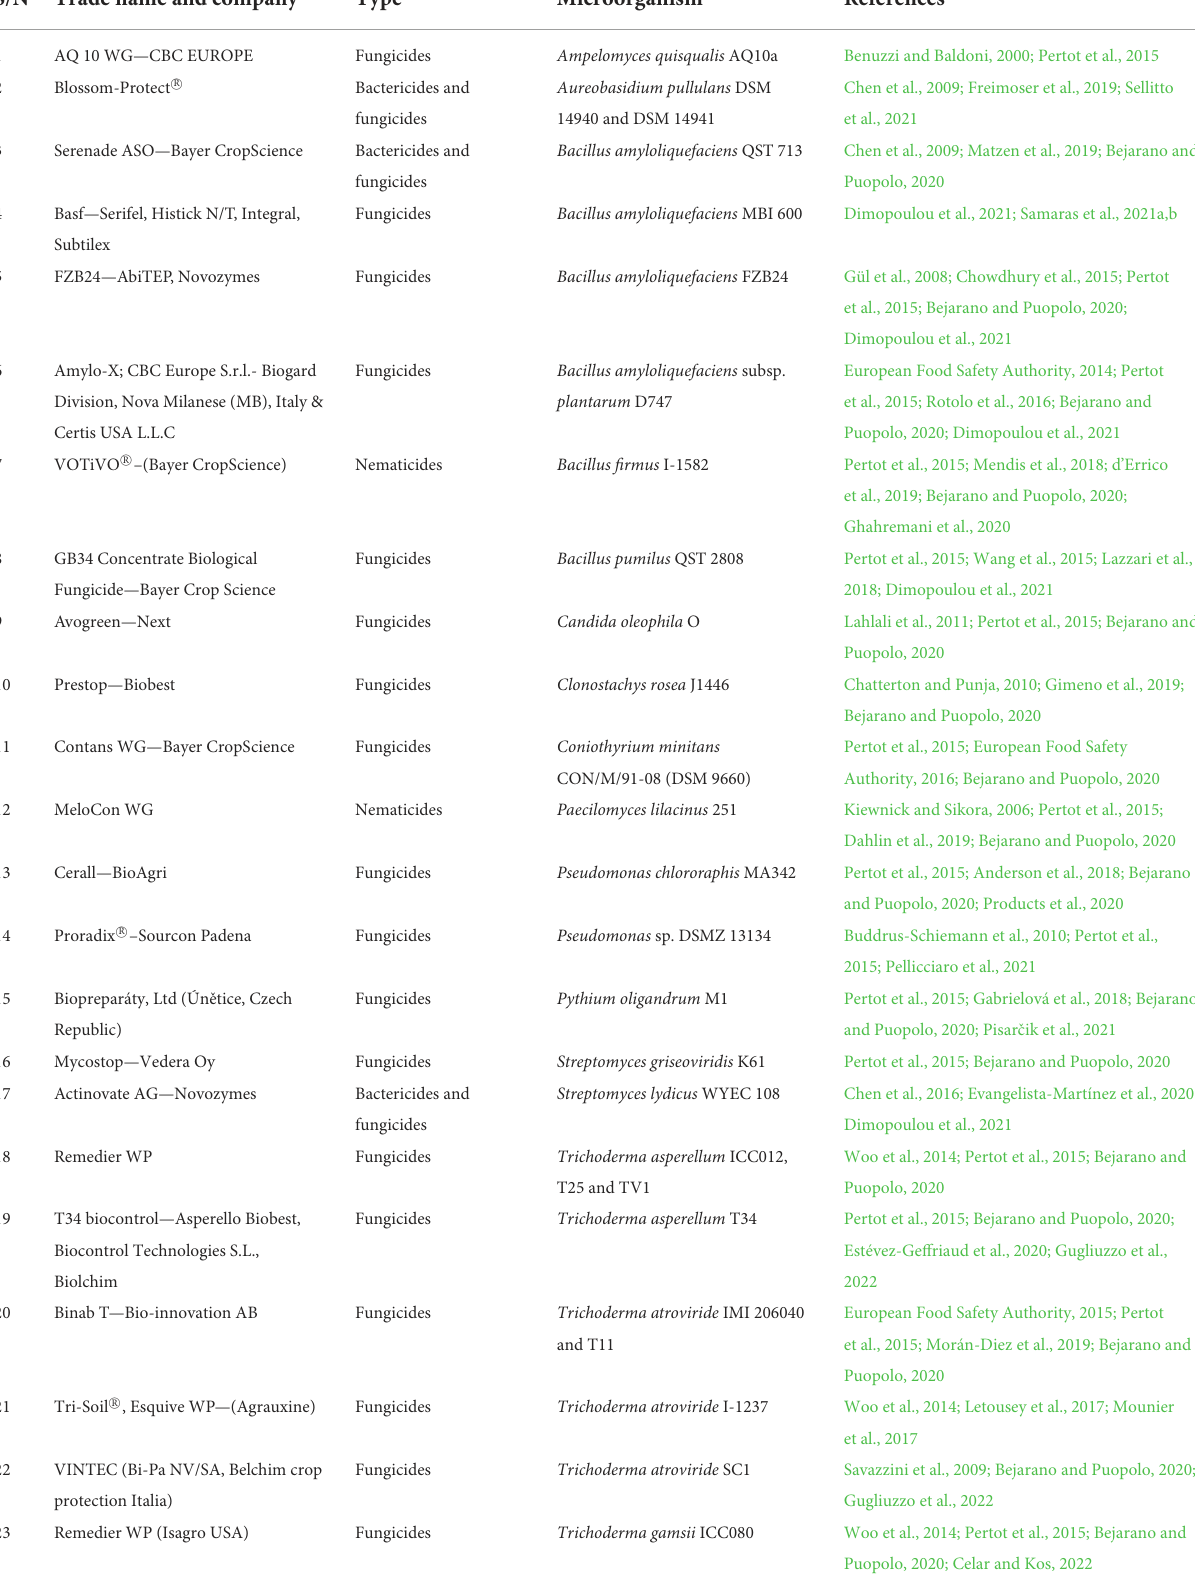
TABLE 2 Commercialized microbial biocontrol